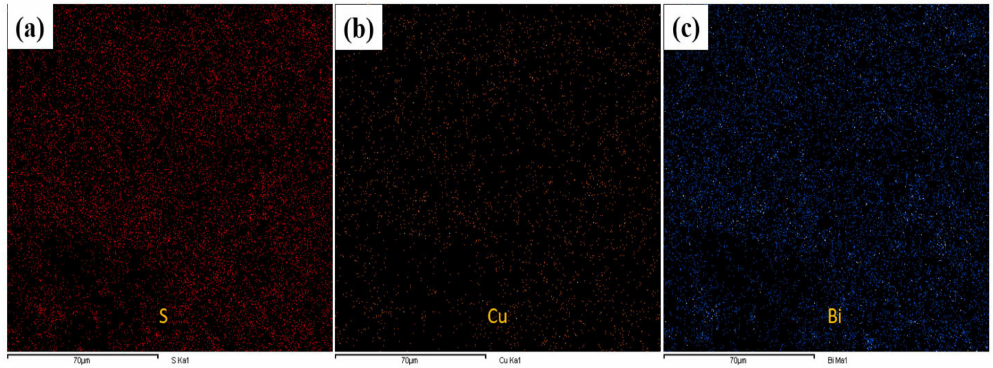
Figure A3. Elemental mapping of Cu 3.21 Bi 4.79 S 9 . It shows the distribution of ( b ) copper, ( c ) bismuth and ( a ) sulphur in the ternary